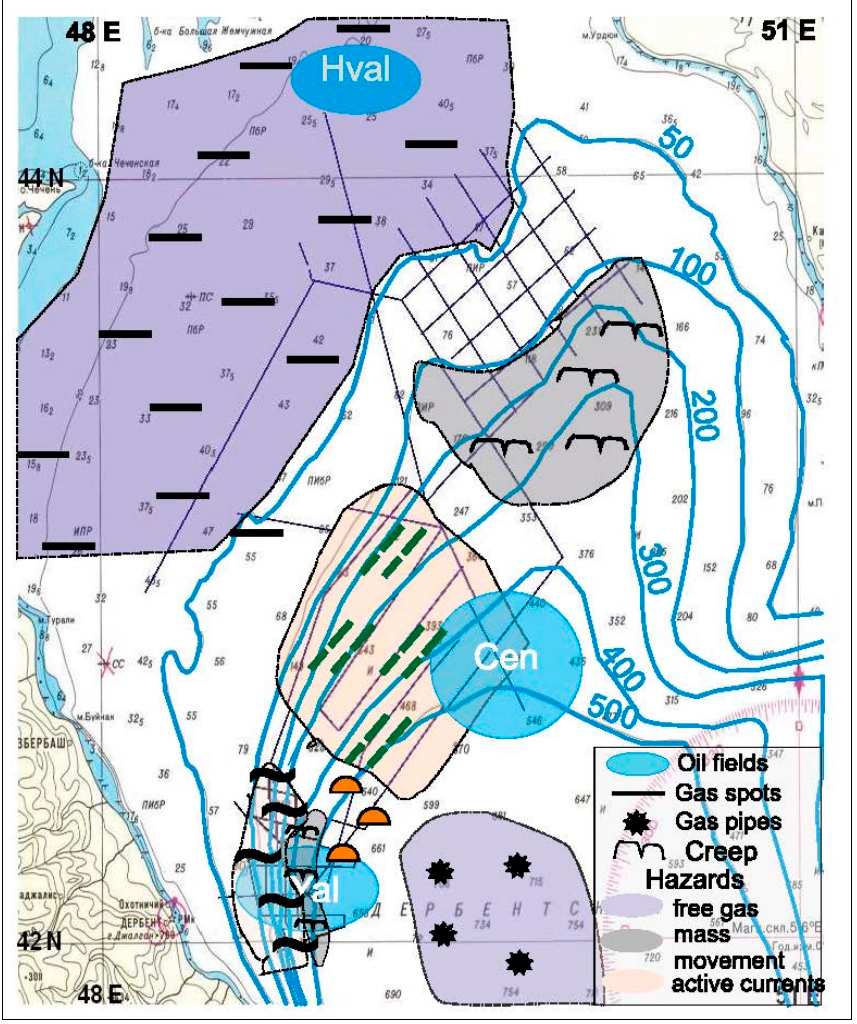
Figure 18. Map of sedimentary features and geohazards. Bathimetry in meters. Oil fields: Hval—Khvalynskoe, Cen—Centralnaya, Yal—Yalama-Samur. For sediment features legend see Figure 17.